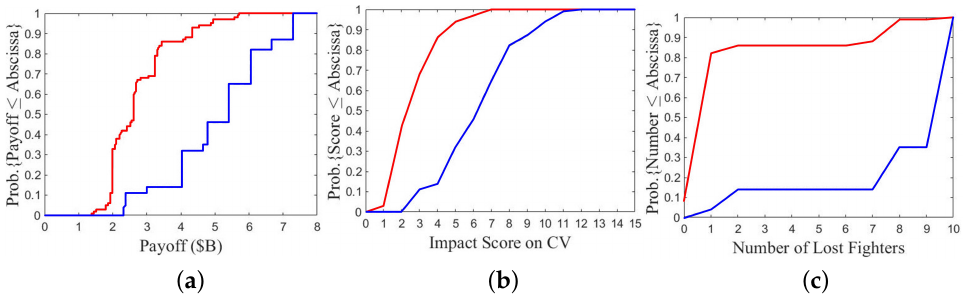
Figure 24. Specific P 2 SO run on A2/B3 over 100 games, cumulative distribution of ( a ) payoff, impact